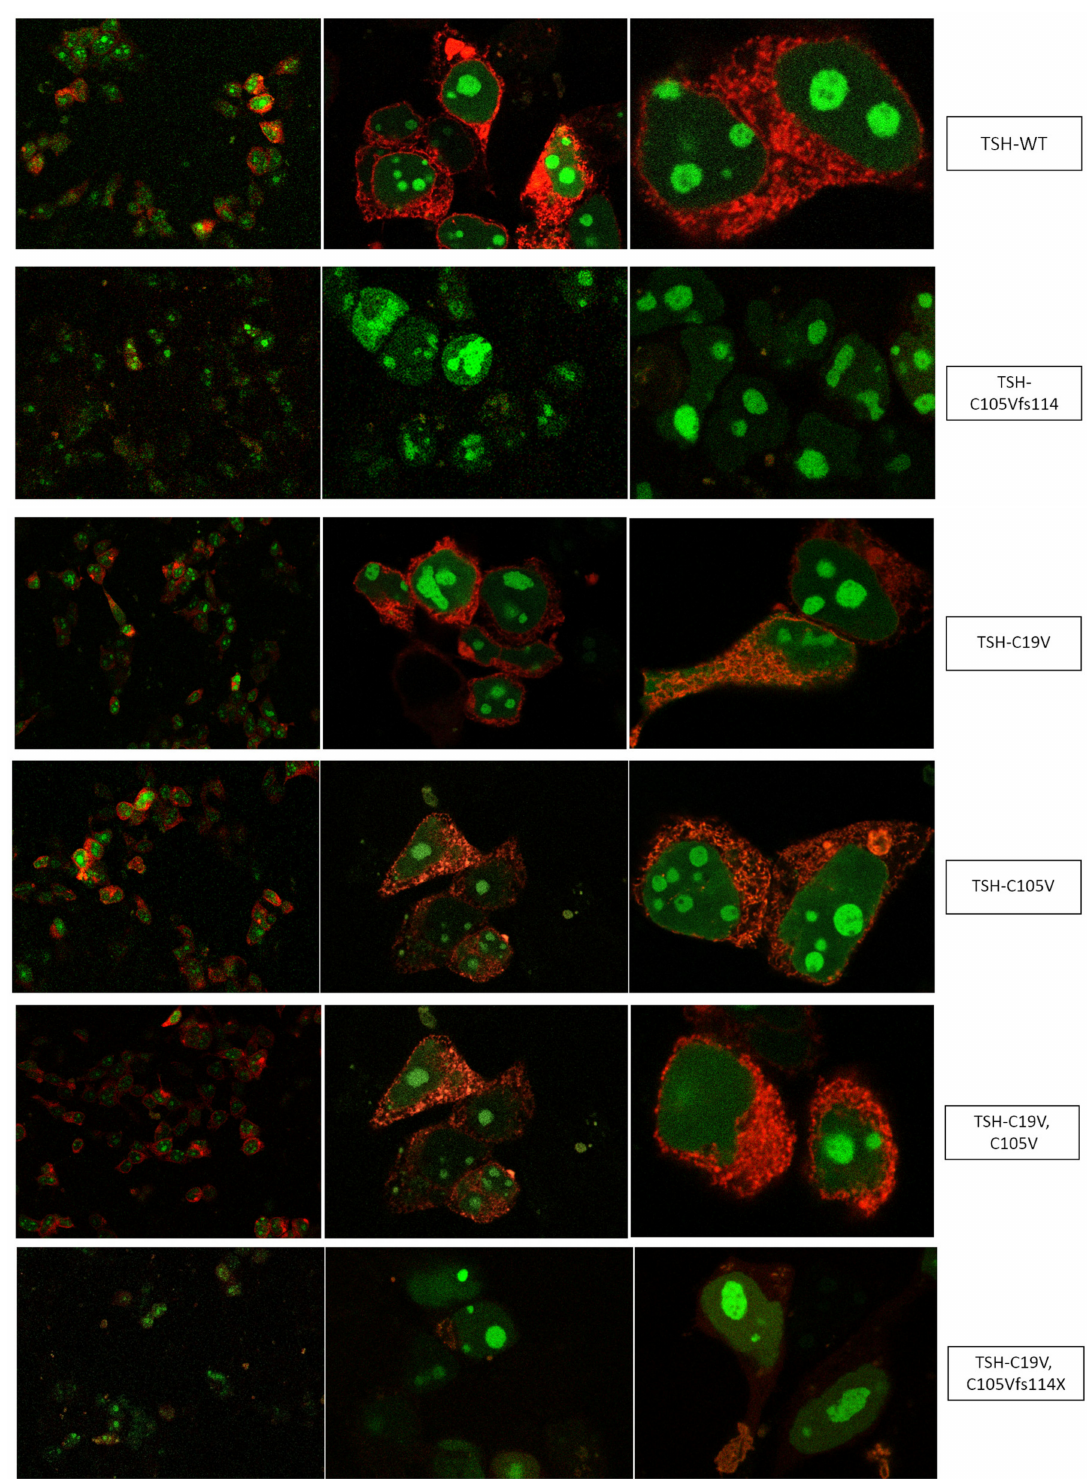
Figure 2. Confocal microscope images showing TSH expression at 20 × , 40 × and 63 × magnification. HEK293 cells were transfected with the α - and β -subunit (latter cloned into the nAmCyan-P2A-mCherry vector) of WT-TSH and mutant TSH. The transfection e ffi ciency and subsequent expression is shown in the green fluorescence (AmCyan). Since the red fluorescence (mCherry) is faded in the frameshift mutations, the comparison is based on the green fluorescent